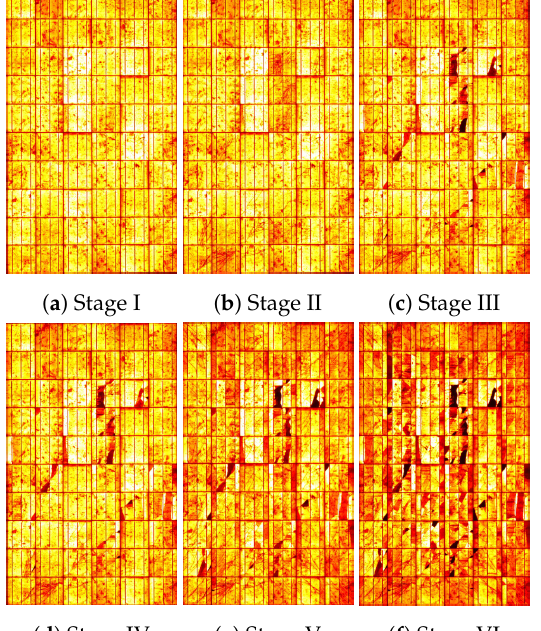
Figure A2. EL images of module #3, measured at STC I sc current bias, before the accelerated stress test (Stage I), and after each stress stage described in Table